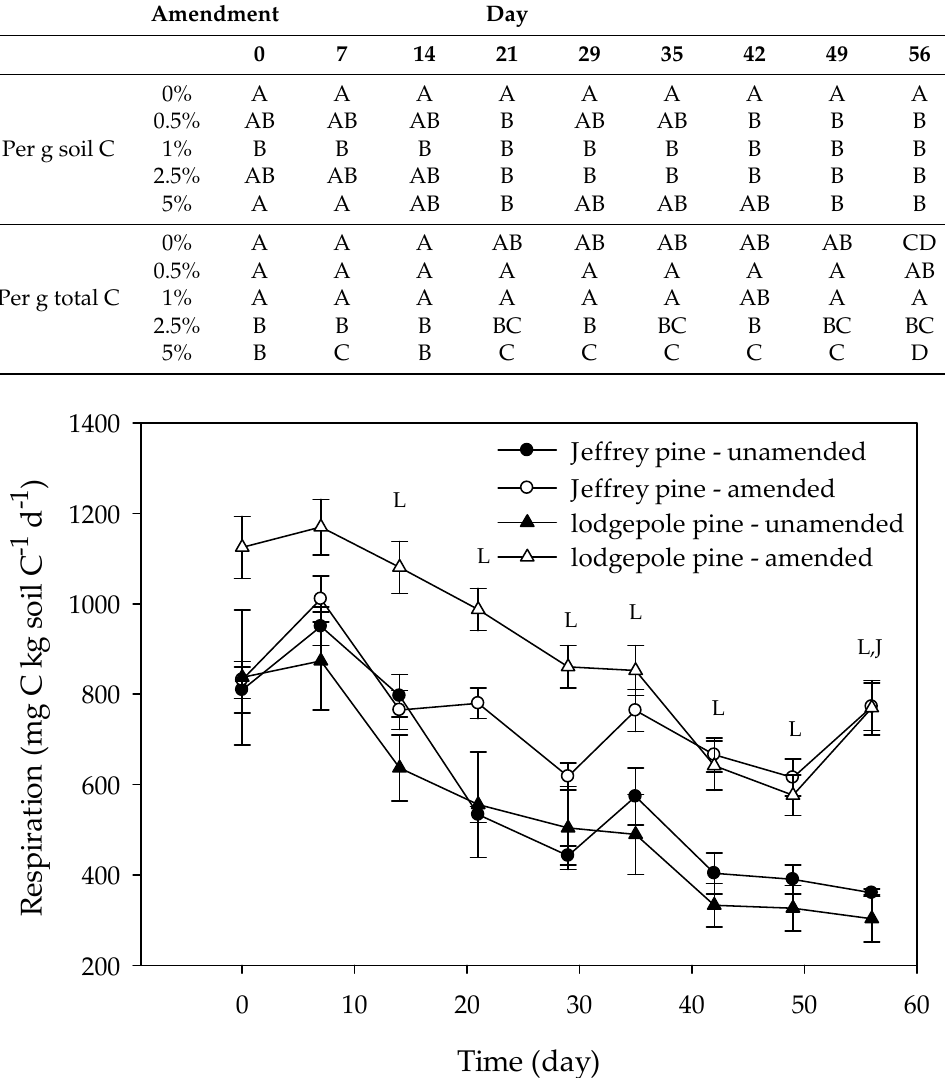
Figure 4. Microbial respiration expressed per gram of soil C in unamended and amended Jeffrey and lodgepole pine soils. Values for amended soils were pooled by amendment level and charcoal type to emphasize how soil type affects the response to charcoal amendment. Day 0 represents the first measurement day following a one-week pre-incubation period. Error bars represent standard errors of the mean ( n = 6 for unamended soils, n = 24 for amended soils). The letters at different measurement times indicate significant ( p < 0.05) differences between unamended and amended Jeffrey pine soils (J) or unamended and amended lodgepole pine soils (L) for that particular measurement time.